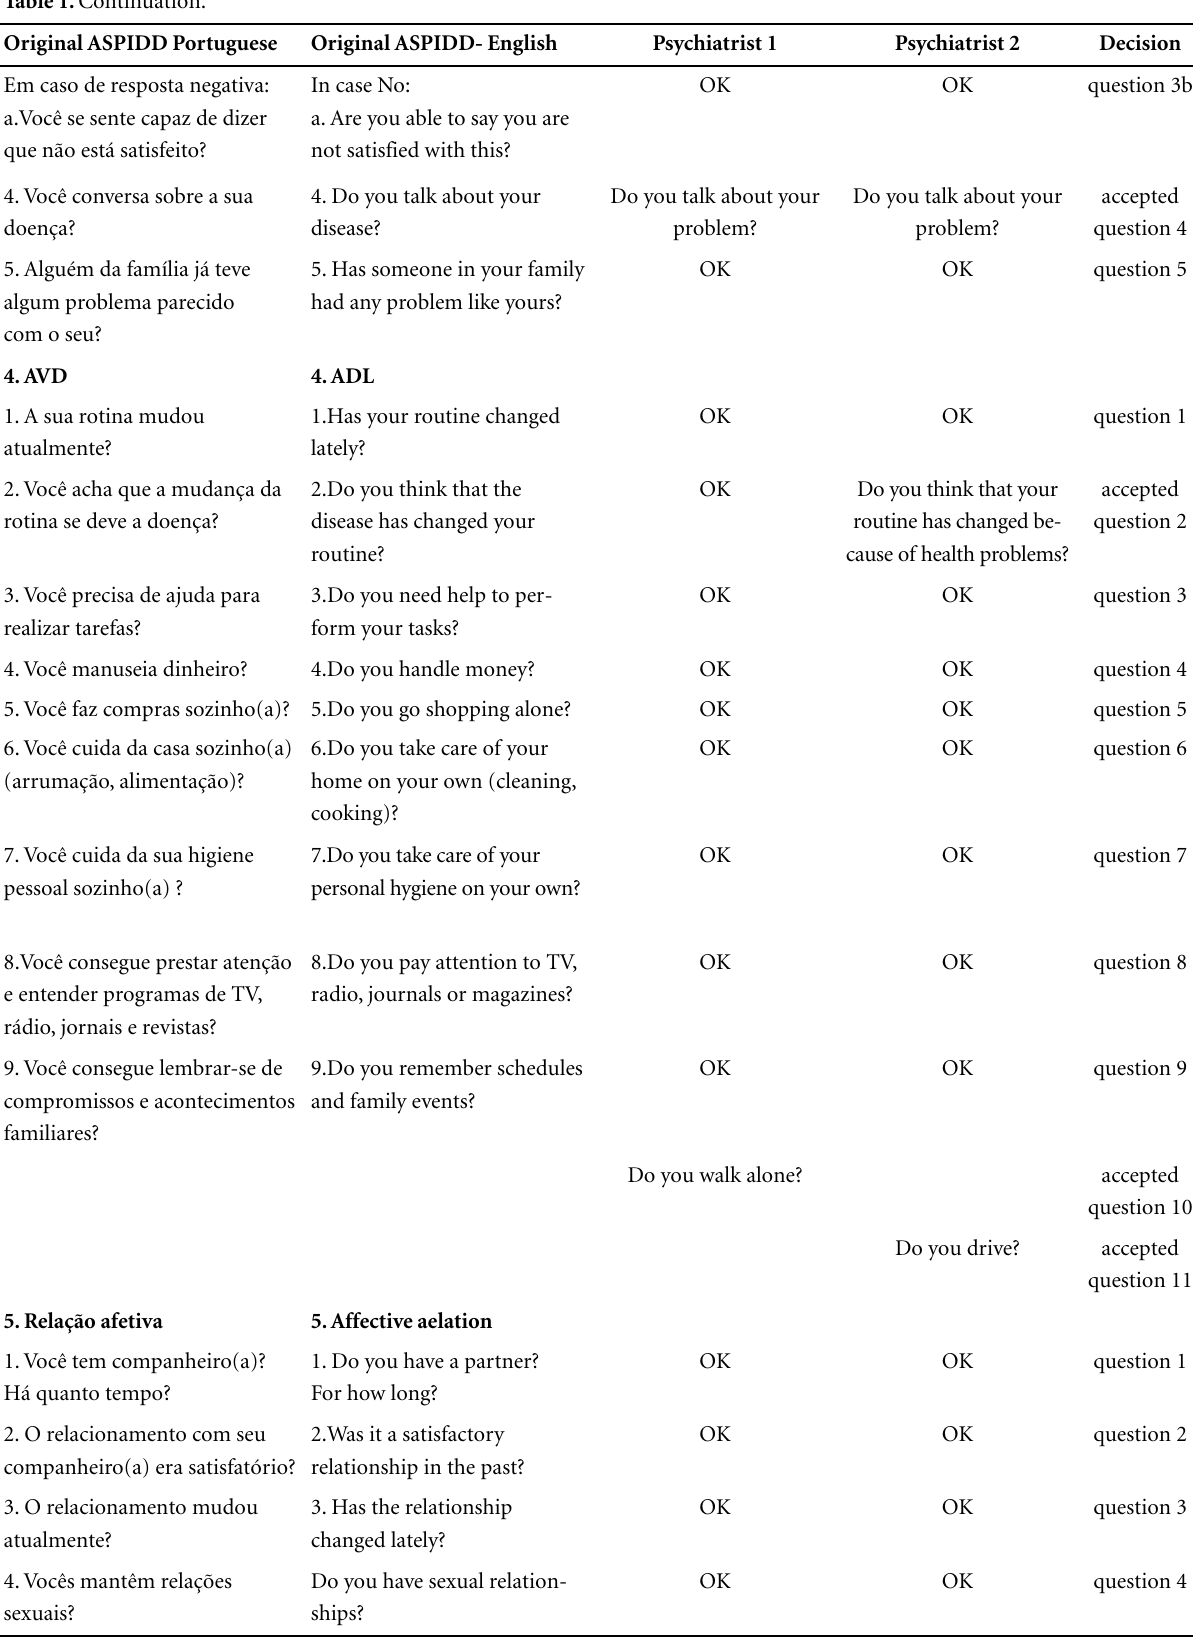
Table 1. Continuation. Original ASPIDD Portuguese Original ASPIDD-